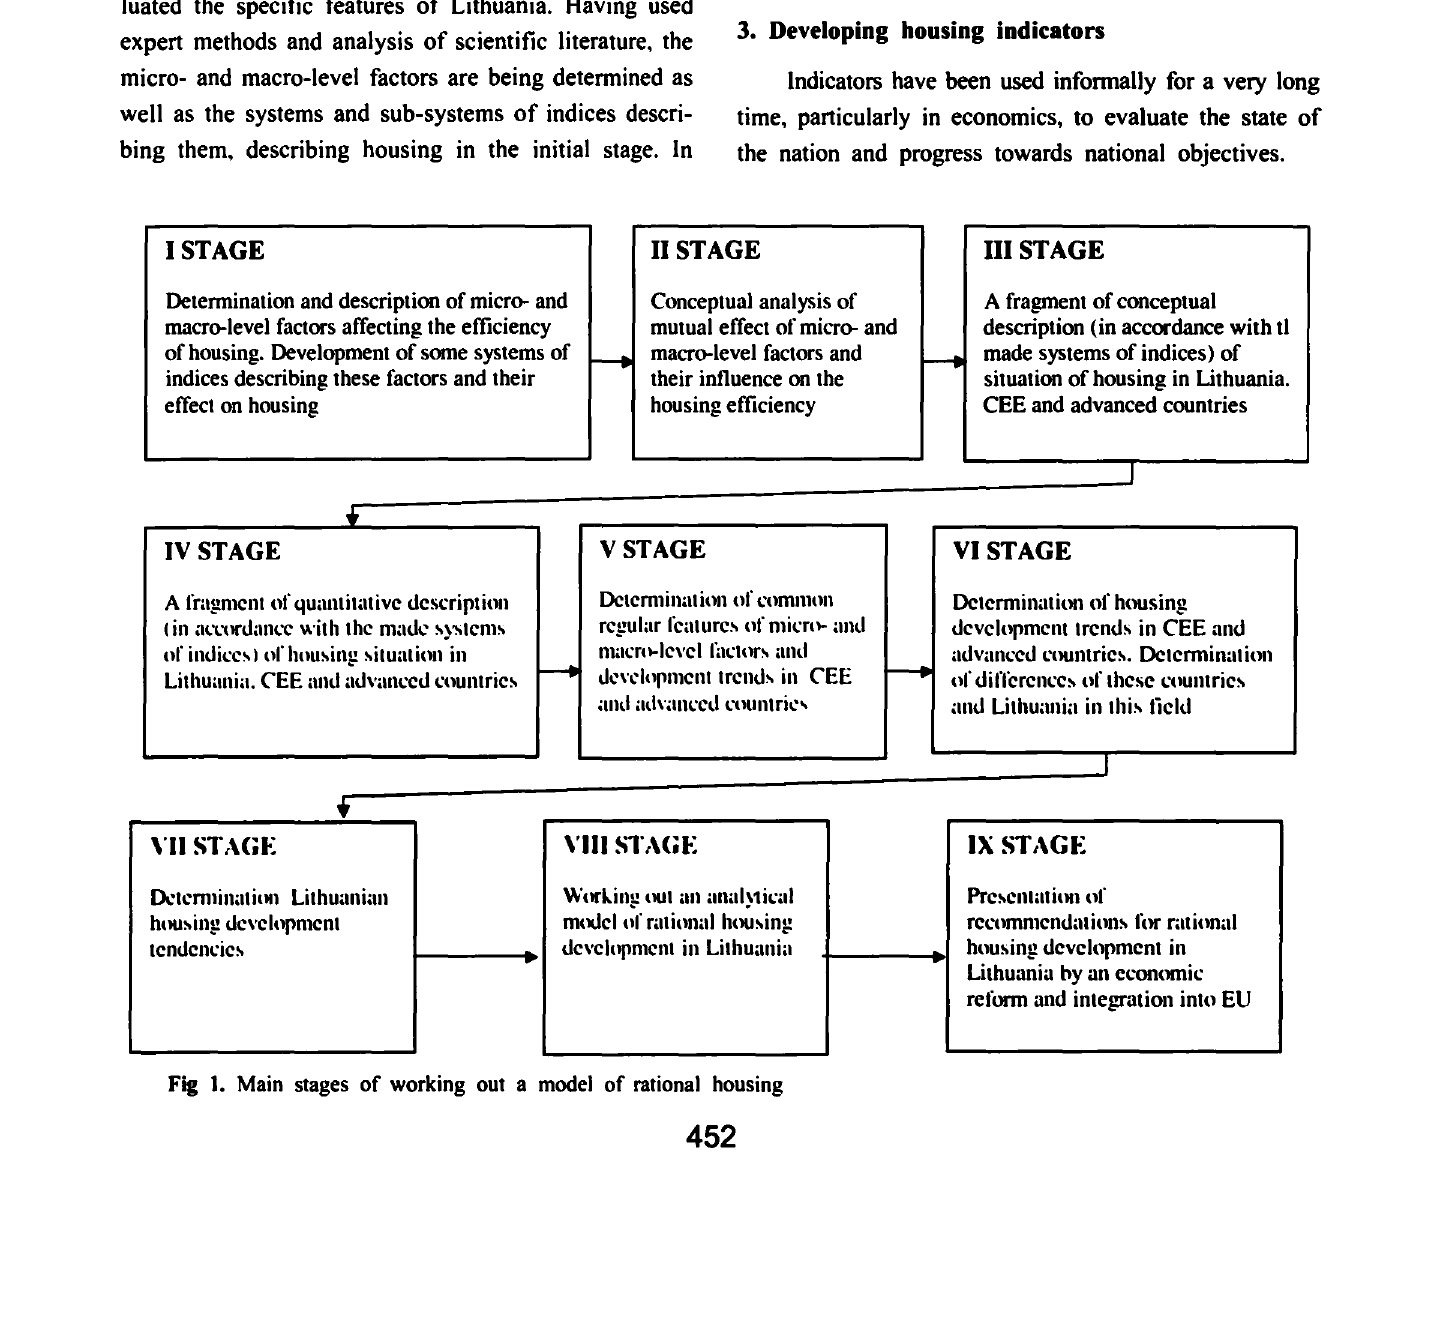
Fig J. Main stages of working out a model of rational